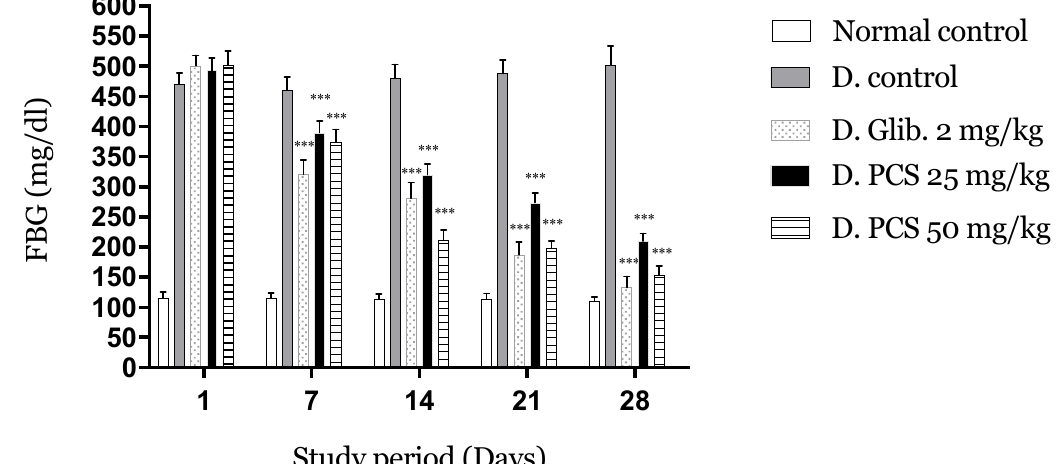
Figure 3. Four-week administration of PCS effect on fasting blood glucose. Values are expressed as mean ± SD ( n = 5 mice). *** p < 0.001 compared to diabetic control. Table 2 indicates the body weight changes of the various experimental groups. For